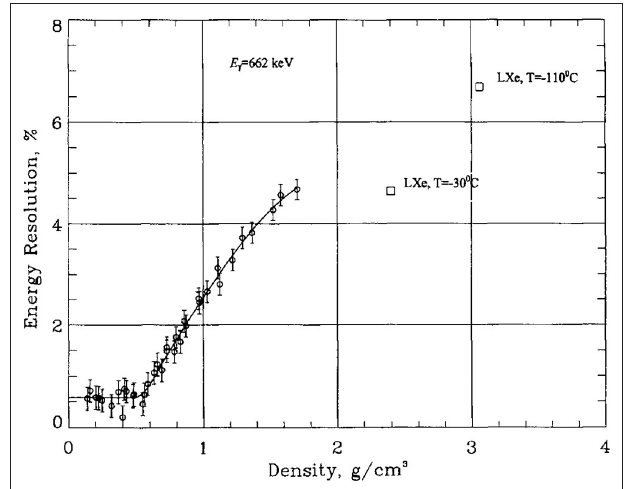
FIGURE 2 | The energy resolution (FWHM) is shown for 137 Cs 662keV gamma rays, as a function of xenon density, for the ionization signal only. Reproduced from Bolotnikov and Ramsey